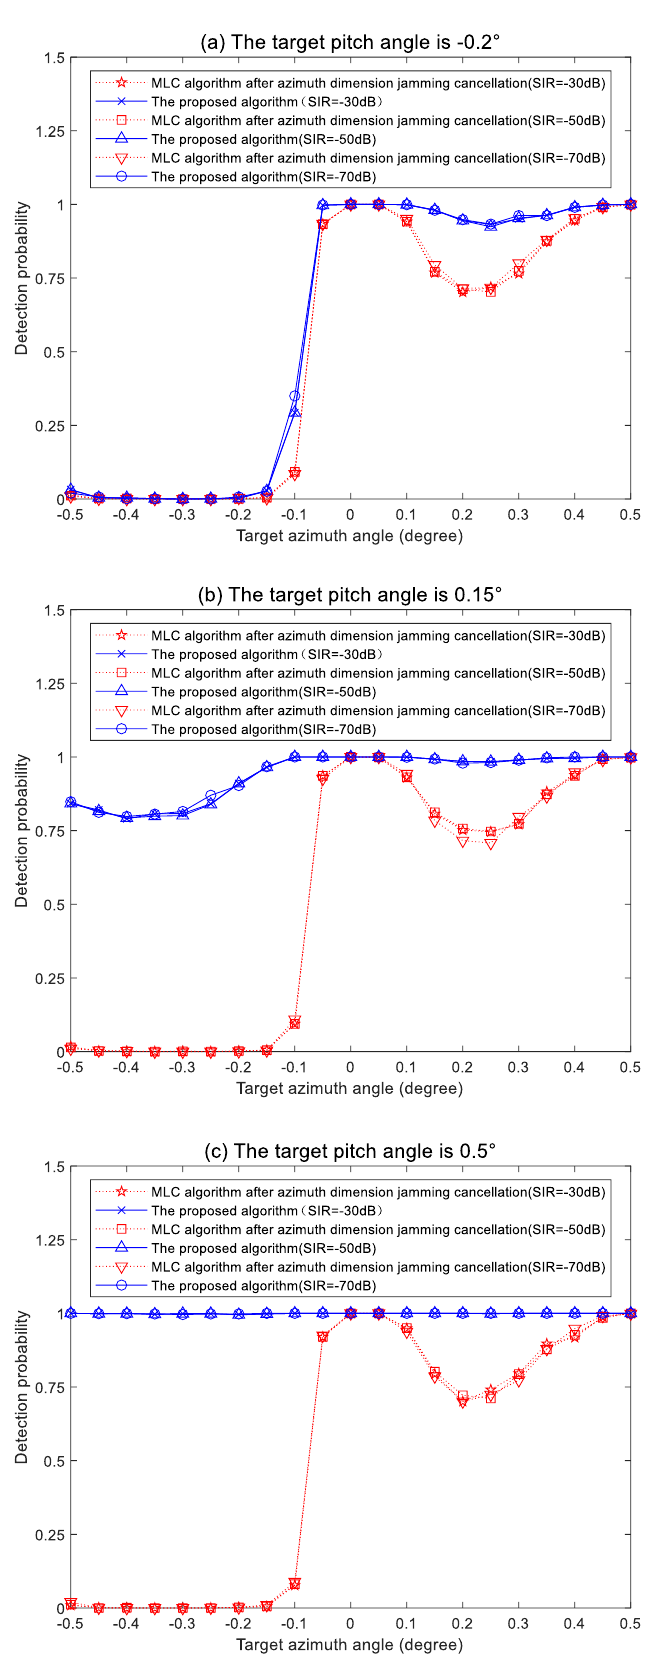
Figure 7. The detection performance of the two algorithms.